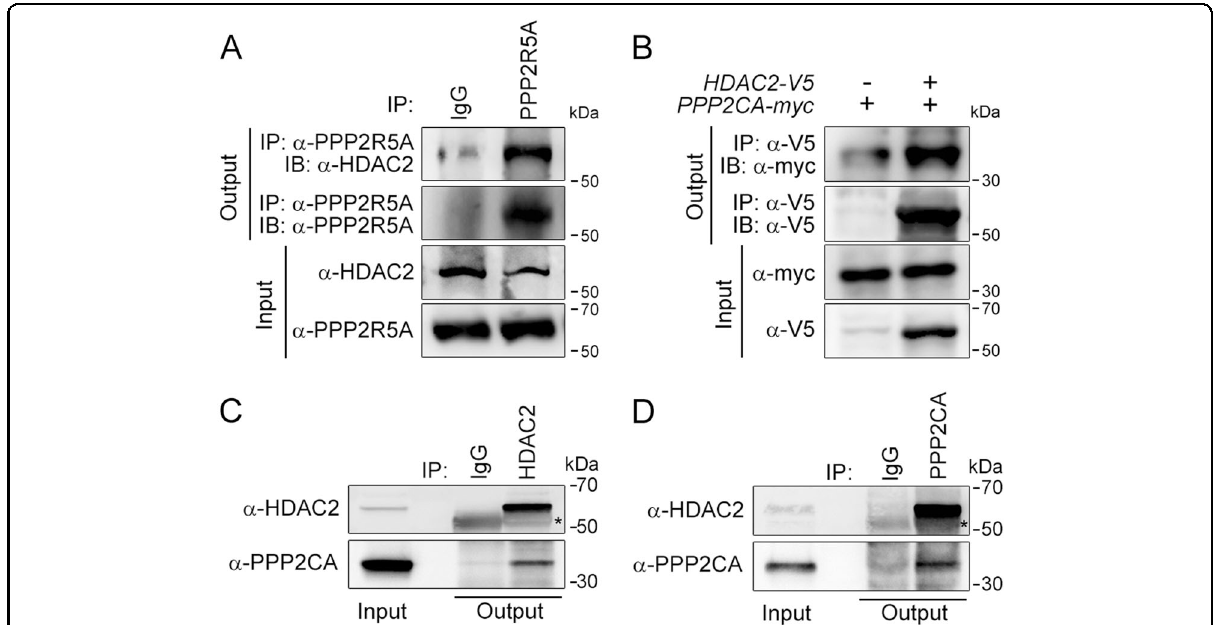
Fig. 1 HDAC2 physically interacts with PP2A. a To con fi rm a physical interaction between PPP2R5A, the regulatory subunit of PP2A, and HDAC2 in NRVCs, primary cultured cardiomyocytes, 2 mg of protein was immunoprecipitated with an anti-PPP2R5A antibody, and the HDAC2 interaction was visualized with an anti-HDAC2 antibody. b – d The catalytic subunit of PP2A, PPP2CA, also bound to HDAC2. To check the interaction in H9c2 cells, a cardiomyoblast cell line, HDAC2-V5 and PPP2CA-myc were transiently transfected, and cells were lysed with 1% NP-40 lysis buffer. Immunoprecipitation was performed with anti-V5 antibody followed by immunoblotting with anti-Myc antibody. c To check the endogenous interaction in NRVCs, primary cultured cardiomyocytes were lysed in 1% NP-40 lysis buffer. Immunoprecipitation was performed with anti-HDAC2 antibody followed by immunoblotting with anti-PPP2CA antibody. d PPP2CA physically interacted with HDAC2 in mouse heart. Two milligrams of heart lysates were immunoprecipitated with anti-PPP2CA. HDAC2 successfully precipitated with